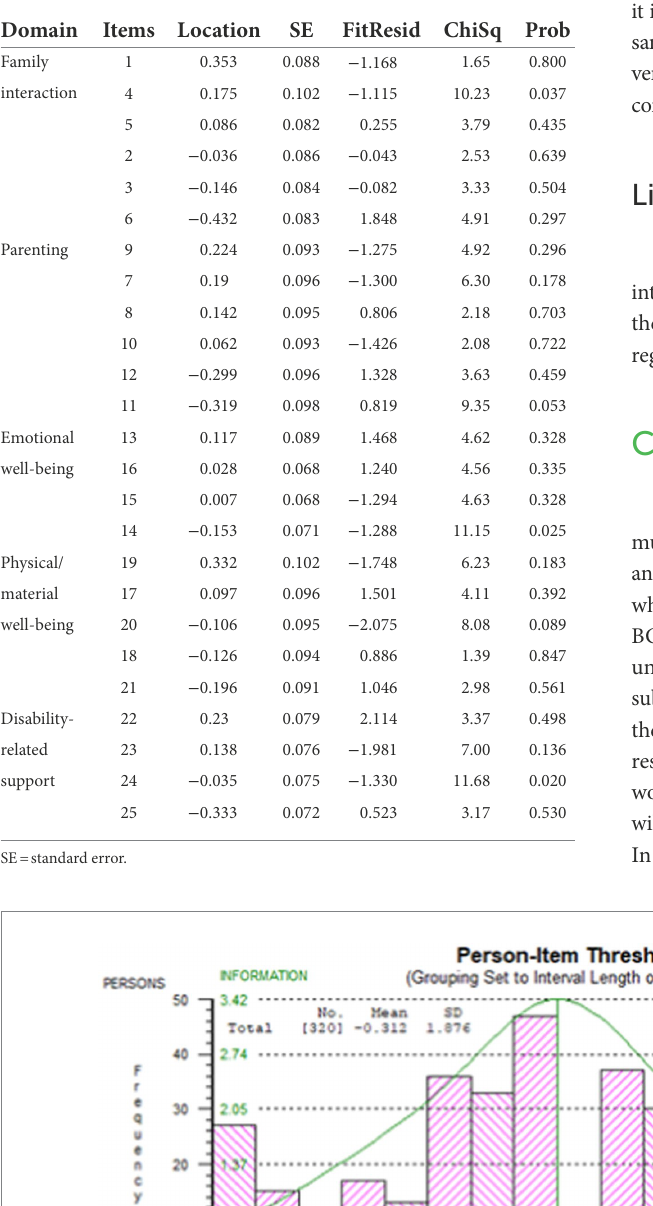
TABLE 3 Item-fit statistics in the Arabic version of FQOL scale sorted from descending based on items location (difficulties to endorse) in each domain.